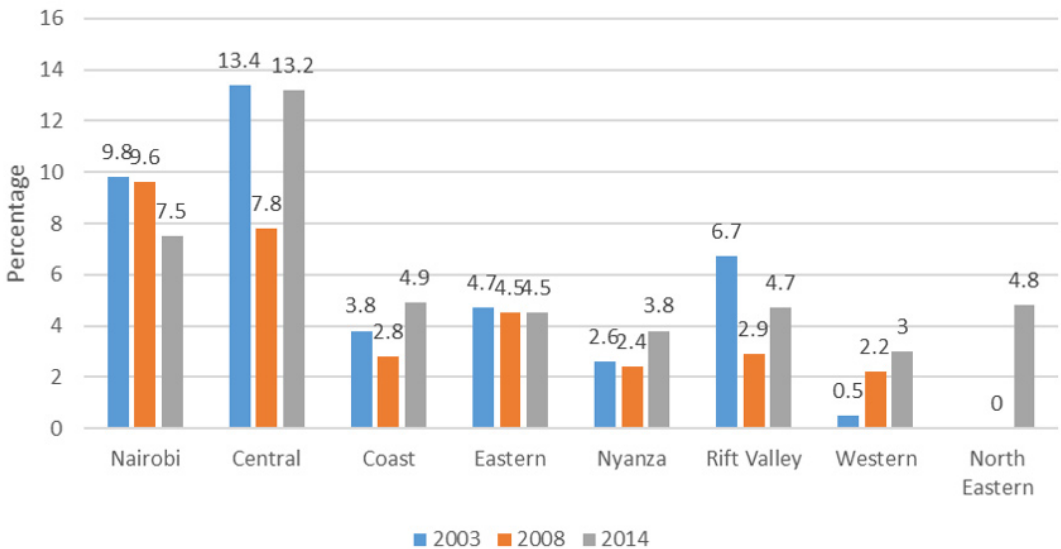
Figure 6. Percentage use of the intrauterine device among modern contraceptives by region, 2003–2014.